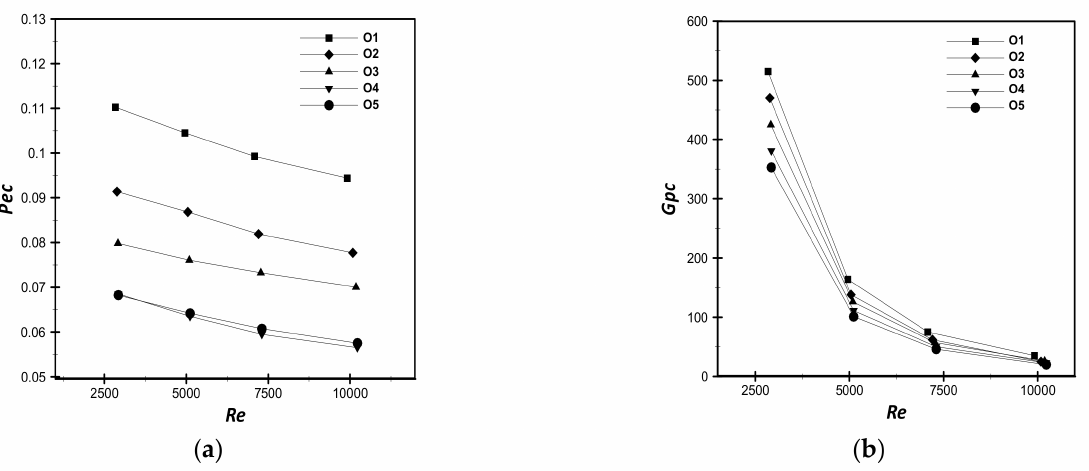
Figure 12. Influence of oval tube shapes and Reynolds number: ( a ) performance evaluation criterion and ( b ) global performance